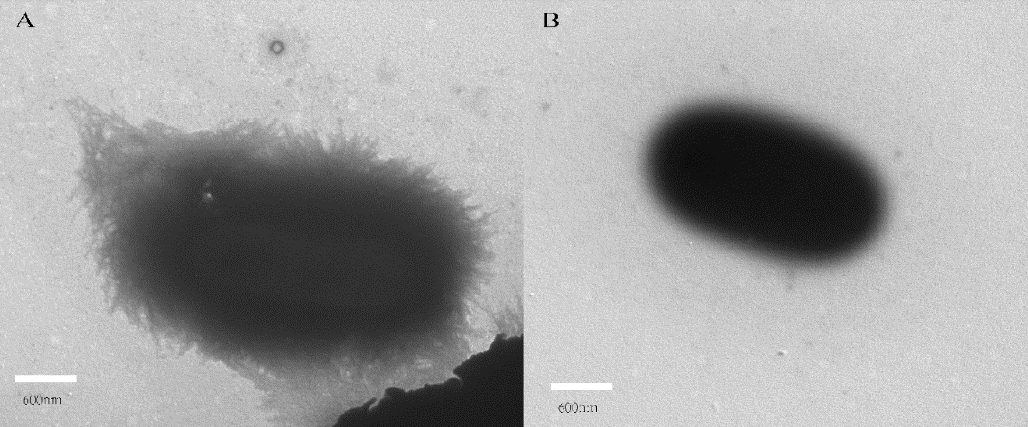
Figure 7. Transmission electron microscopy images of growing UPEC fimbriae. ( A )Untreated UPEC fimbriae and ( B ) dictamnine-treated UPEC fimbriae.